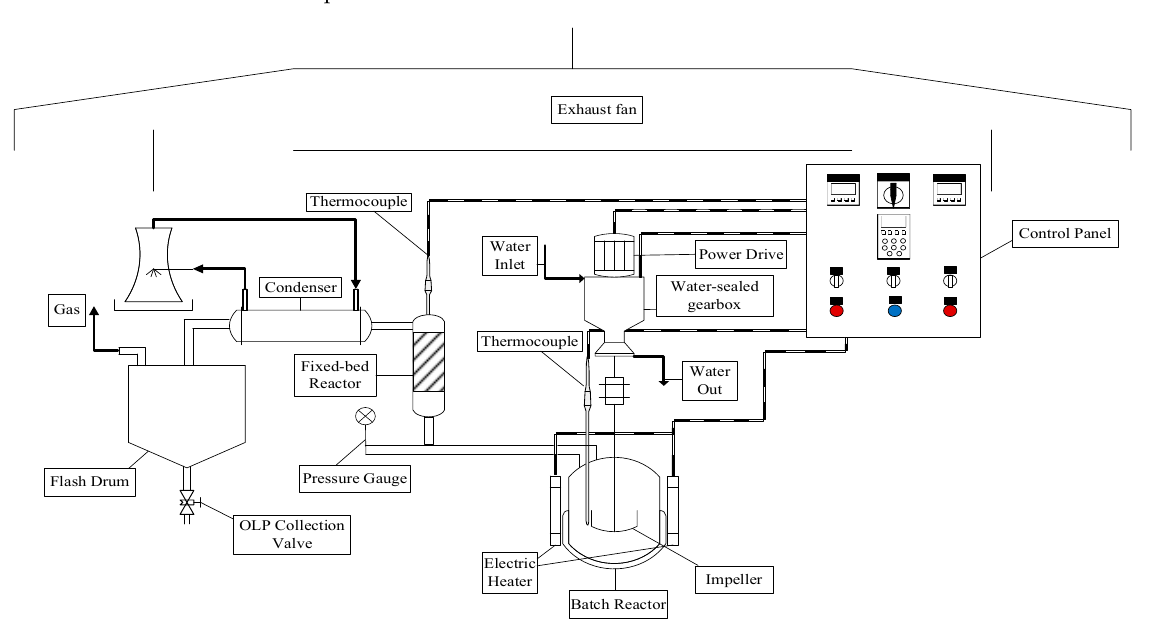
Figure 3. Schematic diagram of bench scale stainless steel catalytic cracking reactor with a pyrolysis/batch reactor and a fixed bed catalytic reactor.